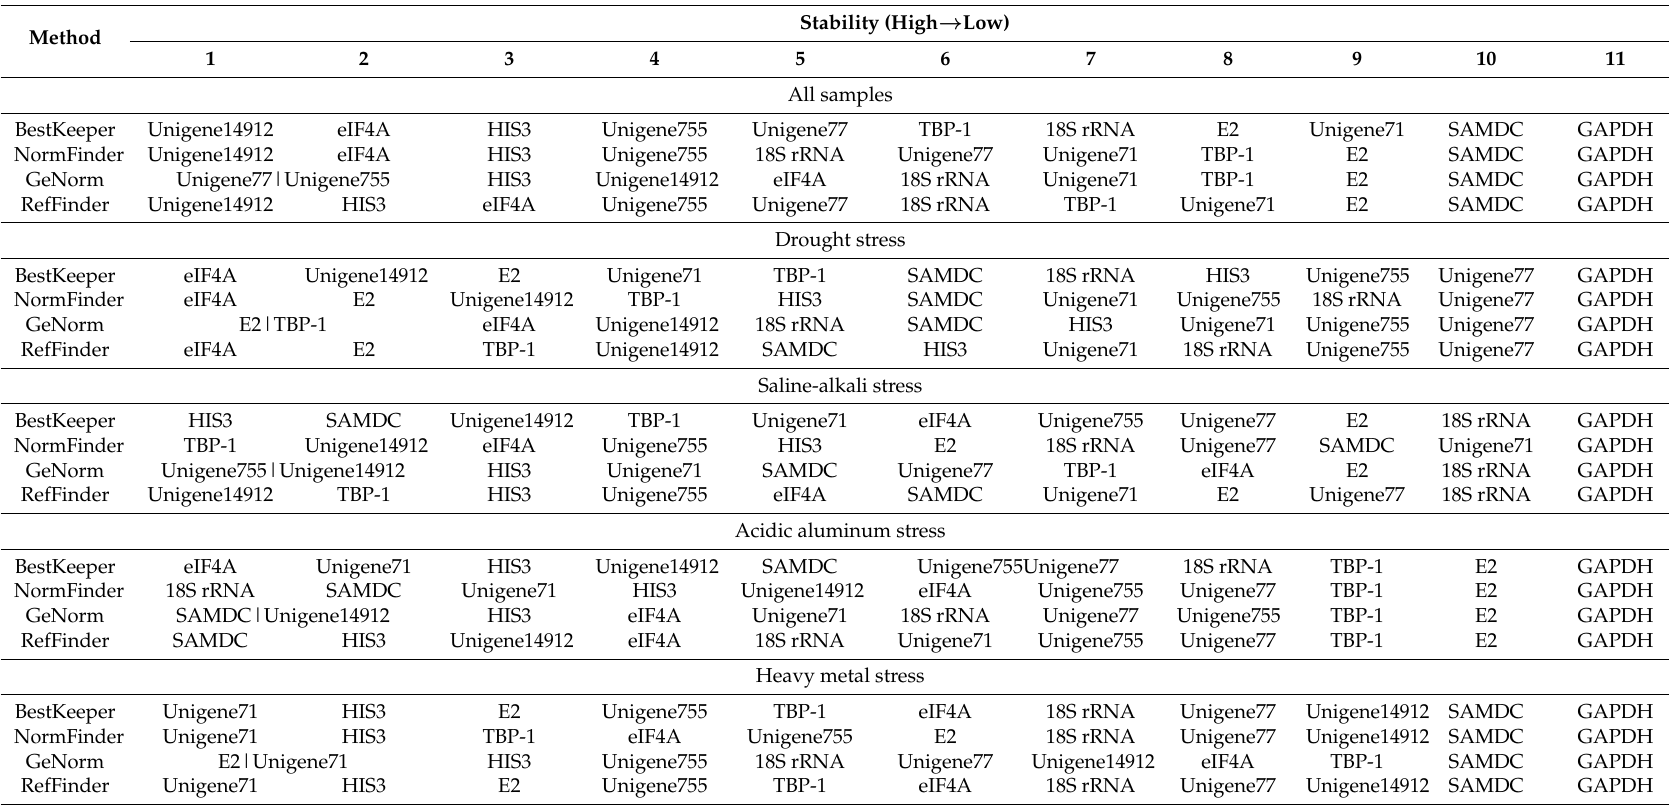
Table 3. Stability ranking of candidate reference